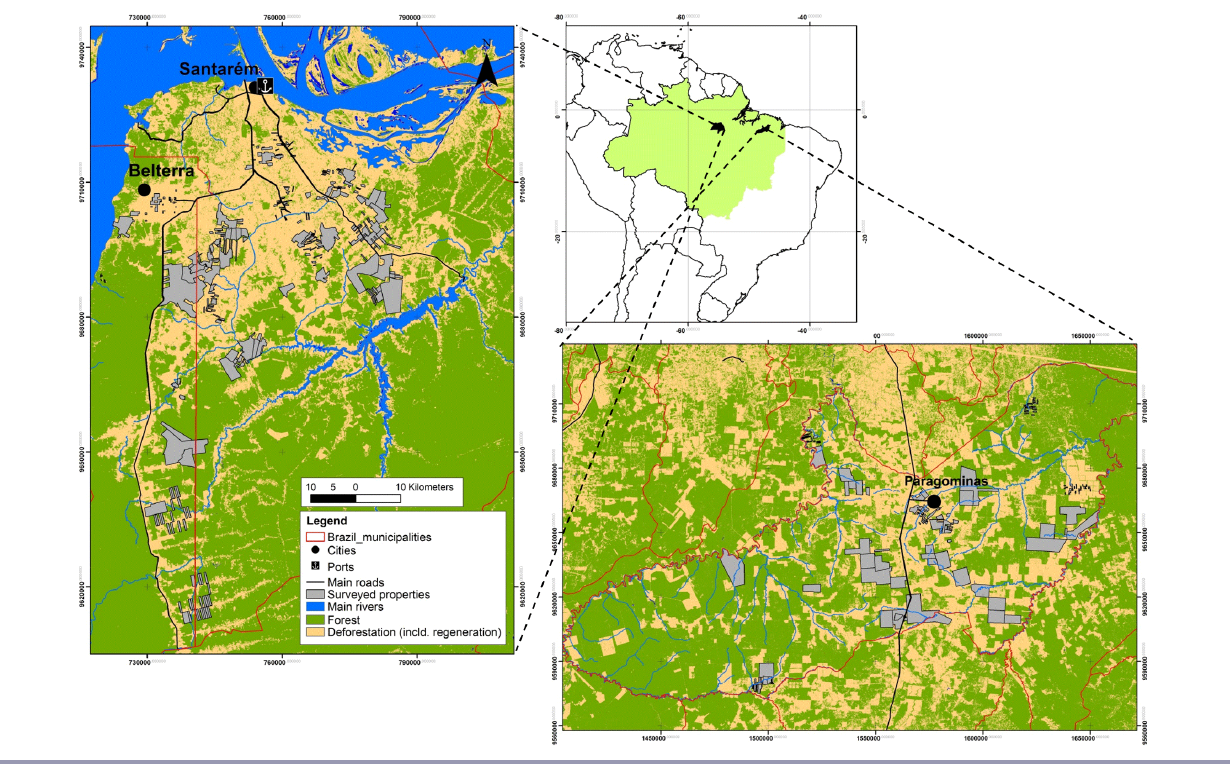
Fig. 1 . Locations of case studies and properties sampled in the Eastern Amazon. Figure (a) Shows the case study region of greater Santarém, which includes the counties of Santarém, Belterra, and Mojui dos Campos.